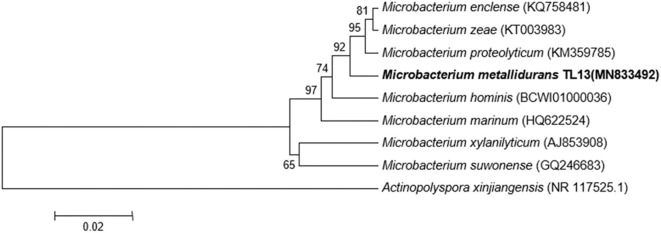
Phylogenetic tree highlighting the position of M. metallidurans TL13 among related taxa within the genus Microbacterium based on 16S rDNA gene sequences. Evolutionary distances were calculated using the method of maximum composite likelihood, and the topology was inferred using the neighbor-joining method using MEGA 7. Numbers on the nodes present % bootstrap values based on 500 replicates. Scale bar represents 0.02 substitutions per site. The 16S rDNA gene sequence of Actinopolyspora xinjiangensis was arbitrarily chosen as the outgroup to define the root of the tree.